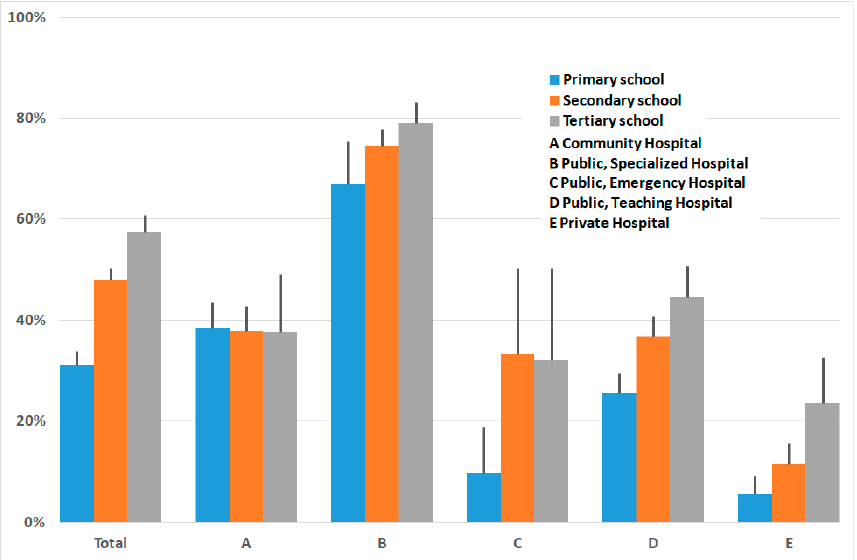
Figure 4. Percentage of exclusive breastfeeding by education level attained by the mother, overall and in various hospital settings. Vertical lines indicate 95% CI.